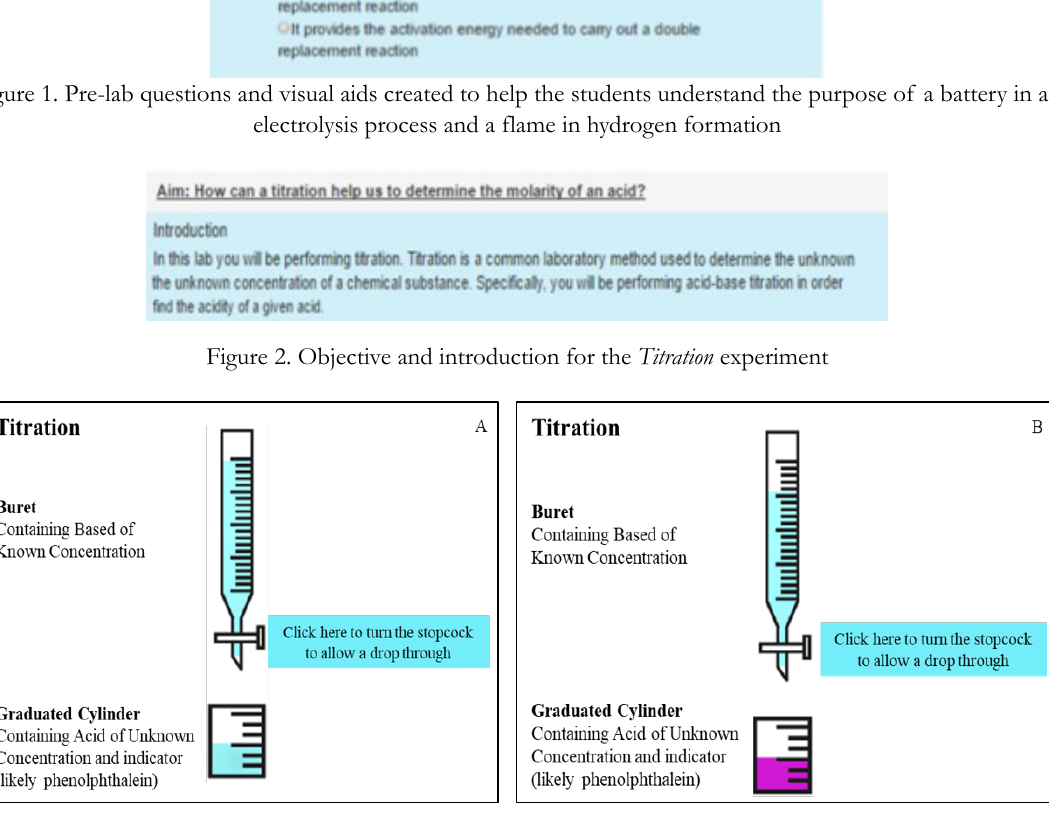
Figure 3. Simulation for the acid-base titration experiment (A) demonstrating how an endpoint is reached (B) once enough base of known concentration has been added from the buret to the beaker containing an acid solution